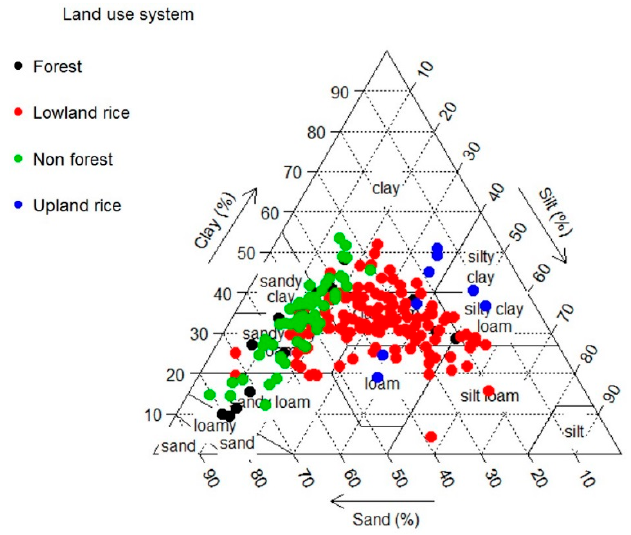
Figure 4. Soil texture triangle for different land-use systems based on the USDA classification. Table 4. Pearson correlation coefficients between soil properties for each system.